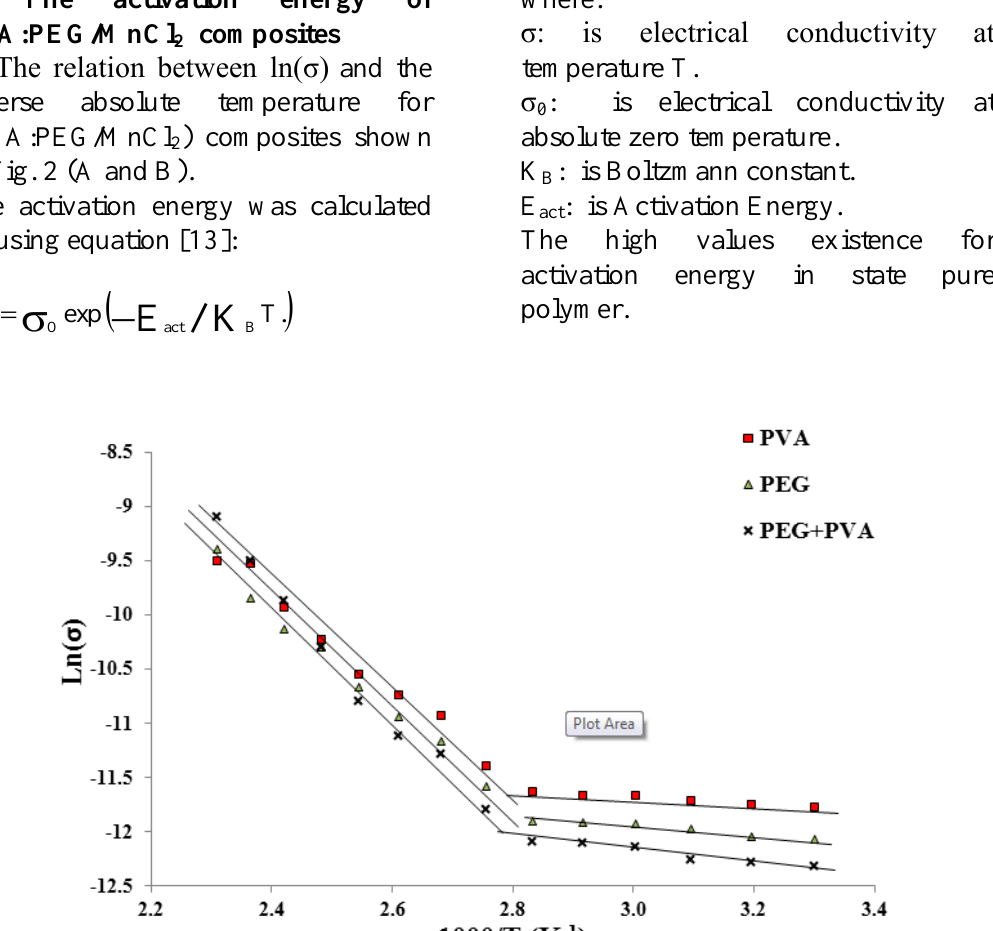
Fig. 2(A): The relation between ln(σ) and the inverse absolute temperature for (PVA, PEG and PVA:PEG) composites.